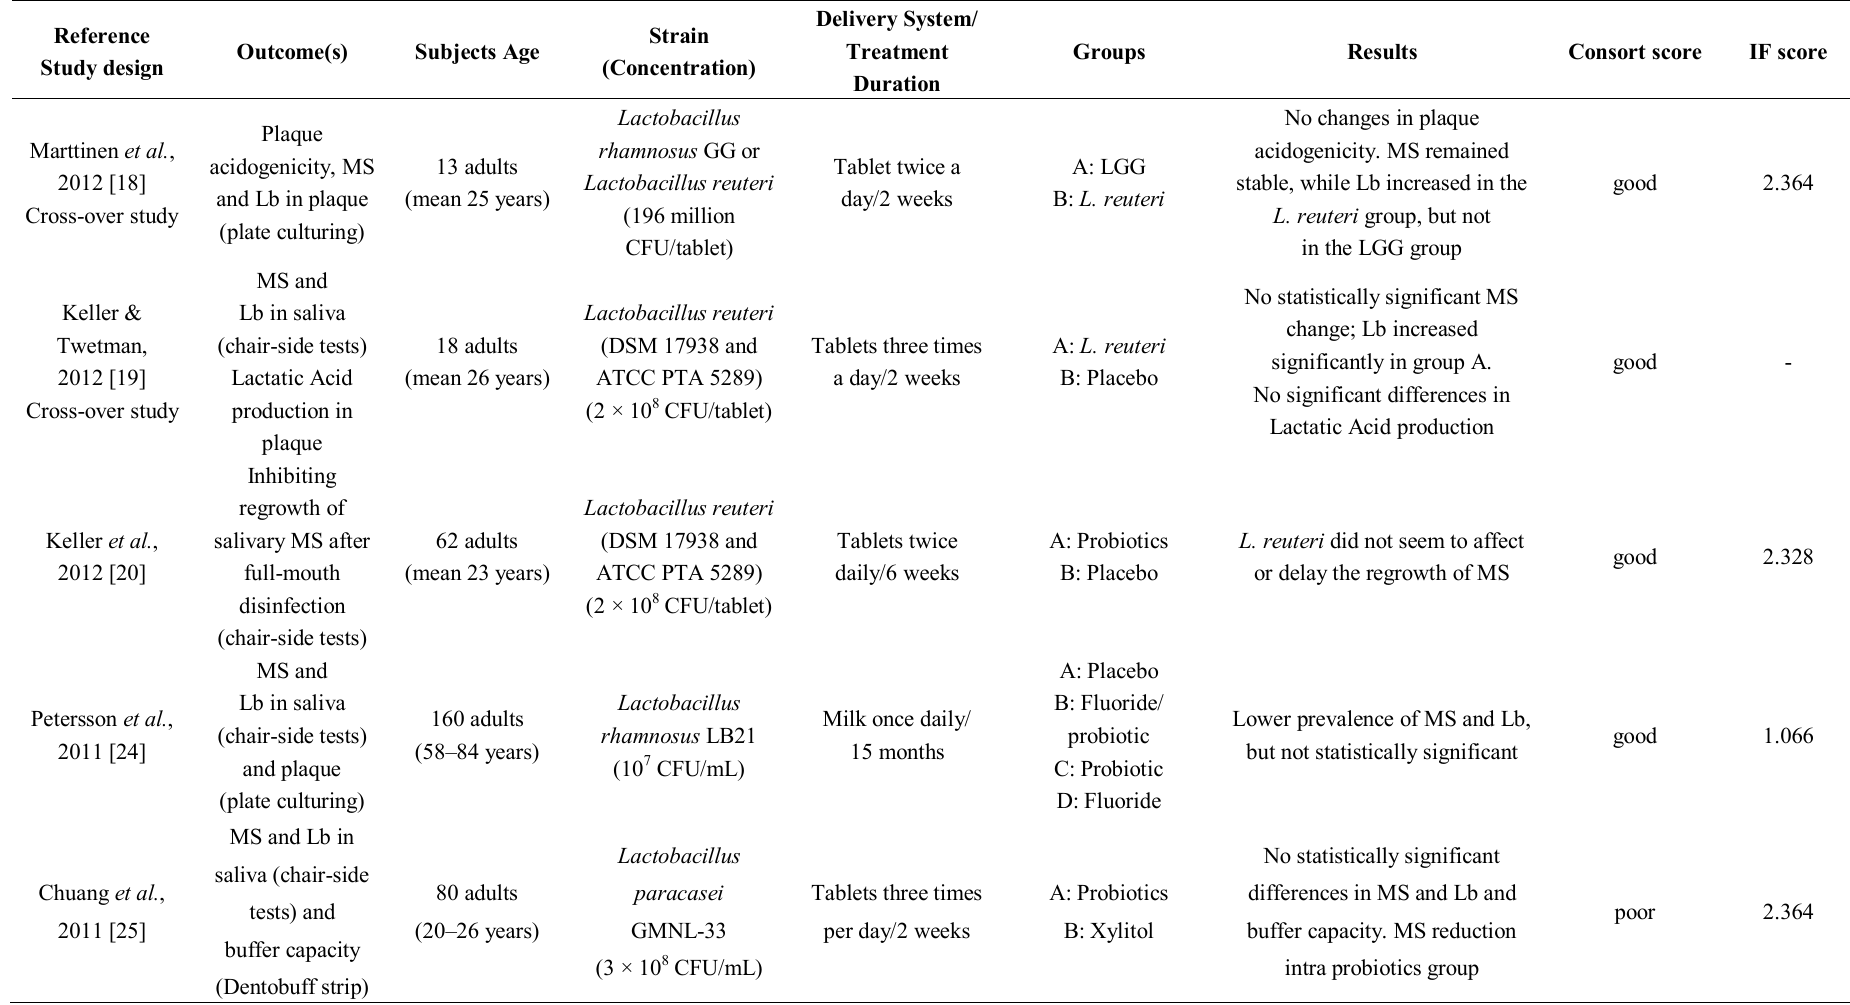
Table 3. Studies with caries risk factors as outcome